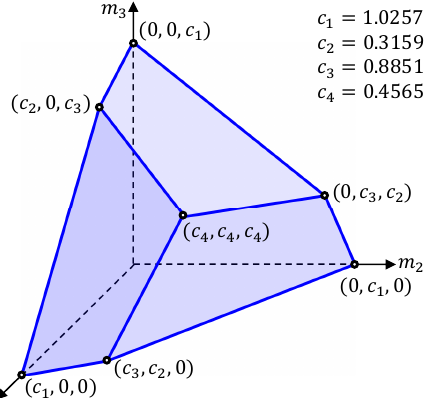
Figure 34. Volume corresponding to linear PWM operation (no overmodulation) in a seven-phase machine, considering optimum zero-sequence (i.e., 1ZS) injection and the worst-case scenario in terms of phase shifts or frequencies of the voltages in each VSD subspace